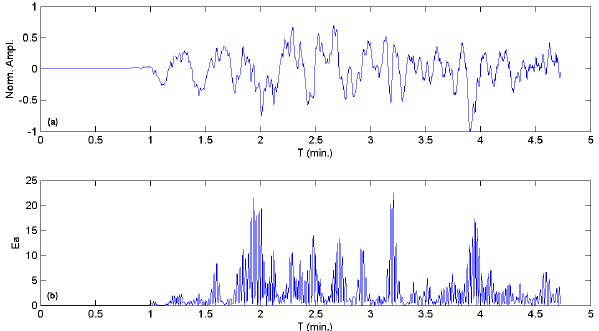
Fig. 4. (a) Seismogram of P-wave train; (b) Ea variation for Suma- tra earthquake (26 December 2004).